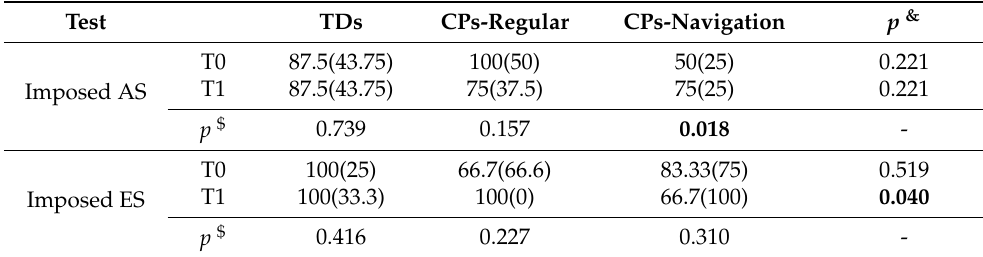
Table 5. Success scores in the trials with imposed allocentric and egocentric strategies, both at T0 and T1, for the whole group of TD, CP-Regular, and CP-Navigation